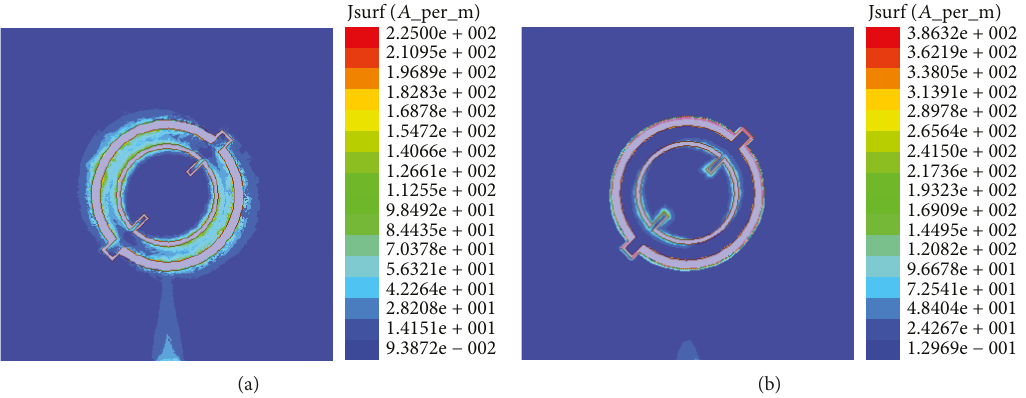
Figure 2: The simulated surface current distributions of the antenna operating at (a) 2.45GHz and (b)